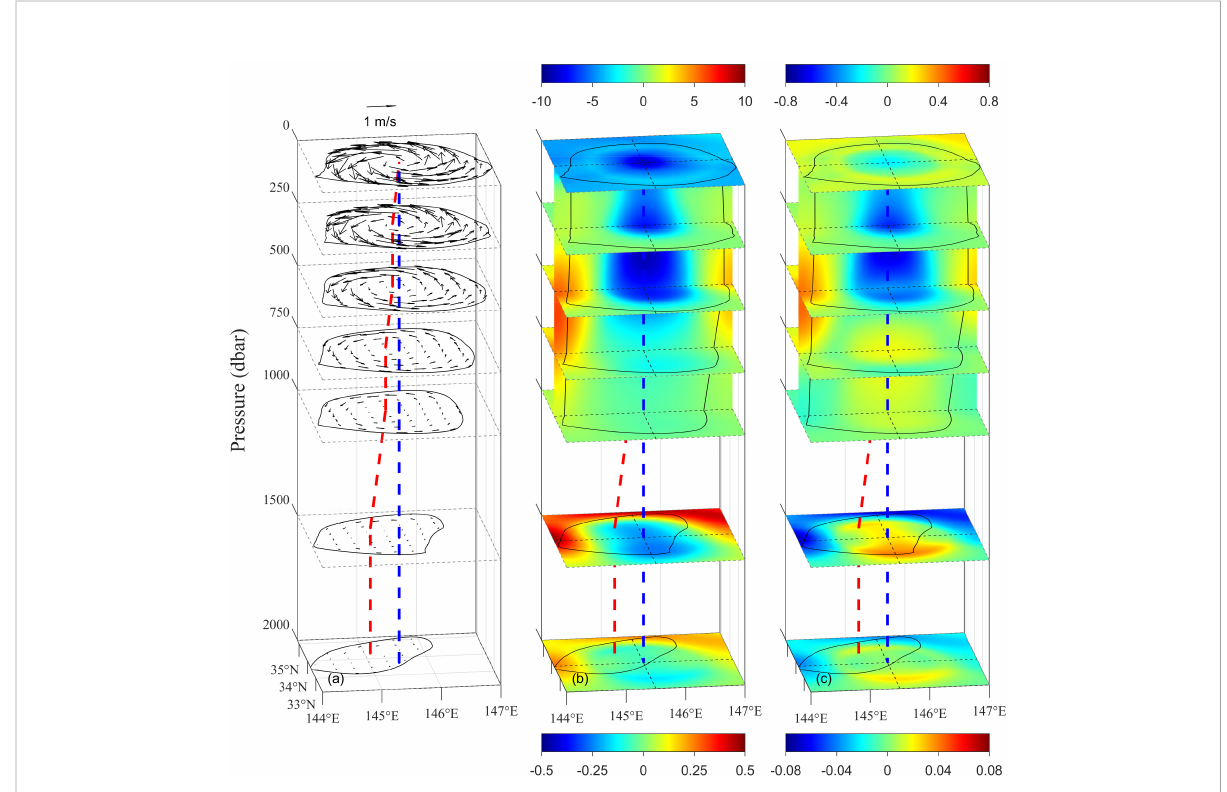
FIGURE 4 Three dimensional view of the (A) velocity (m/s), (B) temperature anomaly (°C), and (C) salinity anomaly (psu) structure of the eddy on February 1, 2005. The red dashed line connects the eddy centers, the blue dashed line is the projection of the surface eddy center on each layer, and the black line indicates the eddy boundary at each